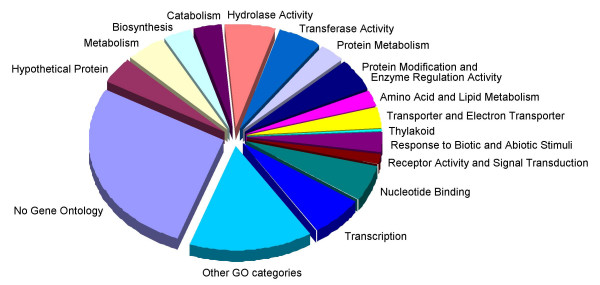
Functional classification of FGAS contigs containing ESTs that are over or under-represented more than 5-fold, or that contain more than 3 unique ESTs. The contigs belonging to the following GO terms were used: GO0008152 Metabolism; GO0009058 Biosynthesis; GO0009056 Catabolism; GO0016787 Hydrolase Activity; GO0016740 Transferase Activity; GO0019538 Protein Metabolism; GO0006464 and GO0030234 Protein Modification and Enzyme Regulator Activity; GO0006519 and GO0006629 Amino Acid and Lipid Metabolism; GO0005215 and GO0005489 Transporter and Electron Transporter Activity; GO0009579 Thylakoid; GO0009607 and GO 0009628 Response to Biotic and Abiotic Stimulus; GO0004872 and GO0007165 Receptor Activity and Signal Transduction; GO000166 Nucleotide Binding; Transcription Factors only from GO0006350 and GO0003677 (other DNA Binding Proteins were transferred to "Other GO categories"); a class was made for the mention "Hypothetical Protein" and for the mention "No Gene Ontology" while the "Other GO Categories" regroups several GO terms with small number of contigs.